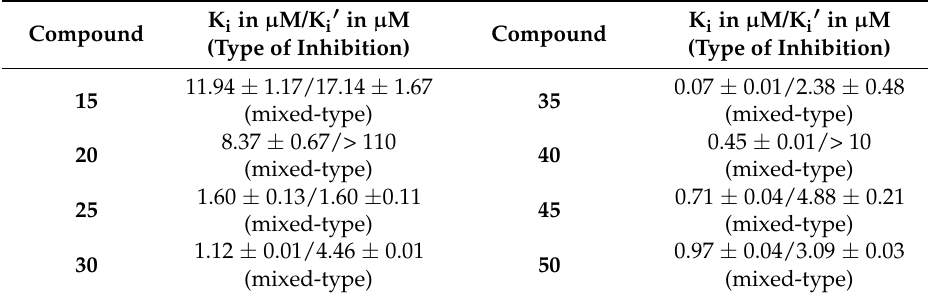
Table 2. Results of the BChE inhibition assay for platanic acid derivatives. Inhibitory constants (K i and K i (cid:48) in µ M), determined using Ellman’s assay employing butyrylcholinesterase (BChE, equine serum) with galantamine hydrobromide ( GH , K i = 2.30 ± 0.17) as